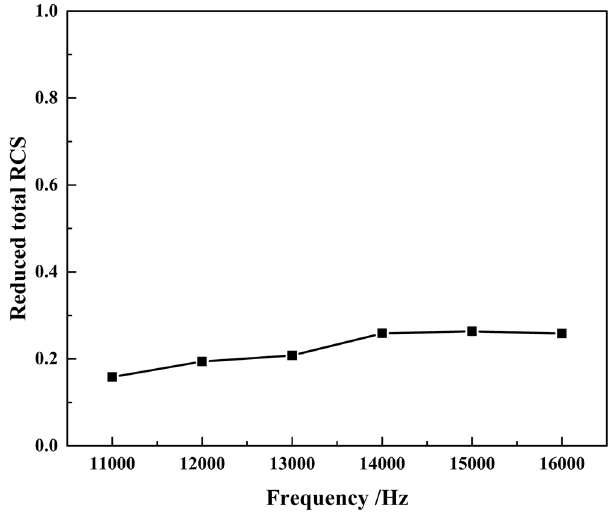
Figure 7. Measured reduced total